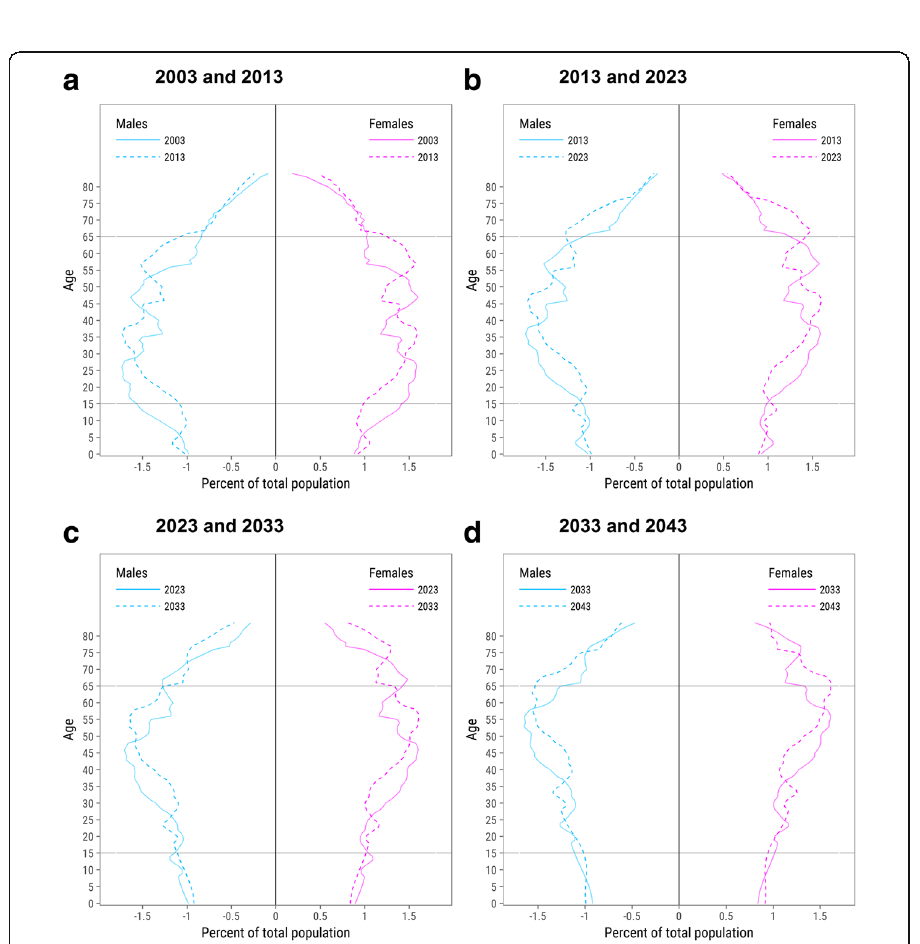
Fig. 11 a – d Population pyramids of Eastern Europe in 2003, 2013, 2023, 2033, and